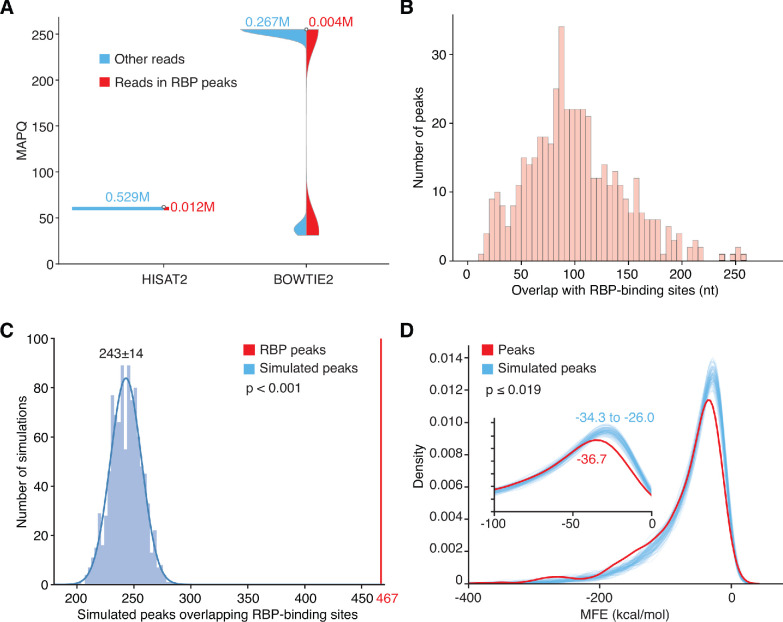
Overlap, quality control, and statistical significance of MACS2-called peaks corresponding to annotated RBP-binding sites.(A) Violin plots of mapping quality (MAPQ) scores for reads in peaks corresponding to RBP-binding sites compared to other long RNA reads with MAPQ ≥ 30, the cutoff for BOWTIE2-mapped reads used in peak calling. HISAT2 and BOWTIE2 use different methods for calculating MAPQ. Reads uniquely mapped by HISAT2 have MAPQ = 60; reads uniquely mapped by BOWTIE2 have MAPQ = 255; and reads mapped to multiple loci by BOWTIE2 have lower MAPQ scores. The MAPQ cutoff of ≥ 30 eliminates BOWTIE2 mapped reads that mapped equally well to more than one locus. (B) Histogram of the number of overlapping nucleotides between the called peaks and annotated-RBP-binding sites in the ENCODE eCLIP datasets. (C) Histogram of the number of simulated peaks overlapping RBP binding sites in 1000 repeat simulations using peaks randomly generated from the sequences of genes encoding long RNAs. In the simulations, 950 peaks with the same size distribution as the 950 high confidence peaks called by MACS2 were randomly generated from the sequences of the genes encoding all long RNAs detected in the combined DNase-treated plasma RNA datasets (n = 15) and checked for overlap with the binding sites for 109 RBPs in the ENCODE eCLIP datasets. In 1,000 repeats of the simulation, the simulated peaks overlapped 201 to 287 RBP-binding sites by chance compared to 467 RBP-binding sites for the plasma RNA peaks called by MACS2 (red vertical line). The simulations indicate that the enrichment of RBP-binding sites in the called RNA peaks is statistically significant (p-value < 0.001). (D) Density plots of the calculated MFEs of the most stable RNA secondary structure predicted by RNAfold for the 709 high confidence long RNA peaks called by MACS2 (467 RBP-binding protein and 242 non-RBP-binding protein peak; red) compared to 709 simulated peaks (blue) with the same size distribution randomly generated from the sequences of genes encoding all long RNAs detected in the combined DNase-treated plasma RNA datasets (n = 15). One hundred repeats of the simulation indicated that the higher predicted stabilities (lower predicted MFEs) of the called long RNA peaks is statistically significant (p-value ≤ 0.019).